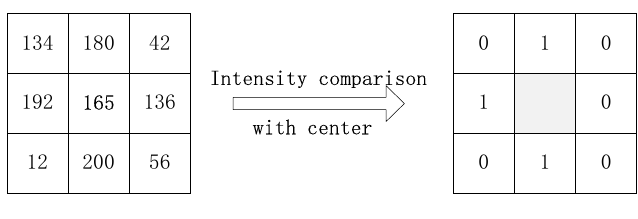
Figure 1. Example of an LBP